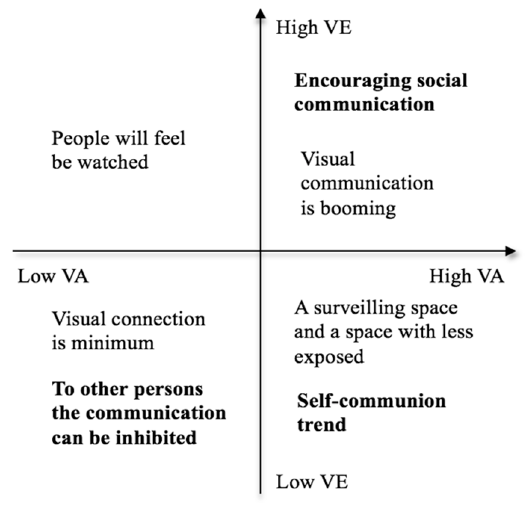
Figure 1. The relationship between VA, VE and psychological health features in the social commu- nity.